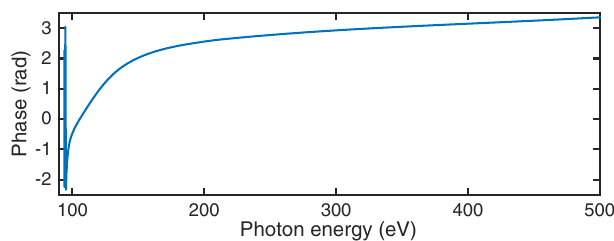
FIG. 7. Calculated dipole emission phase for Kr 3 d as a function of photon energy